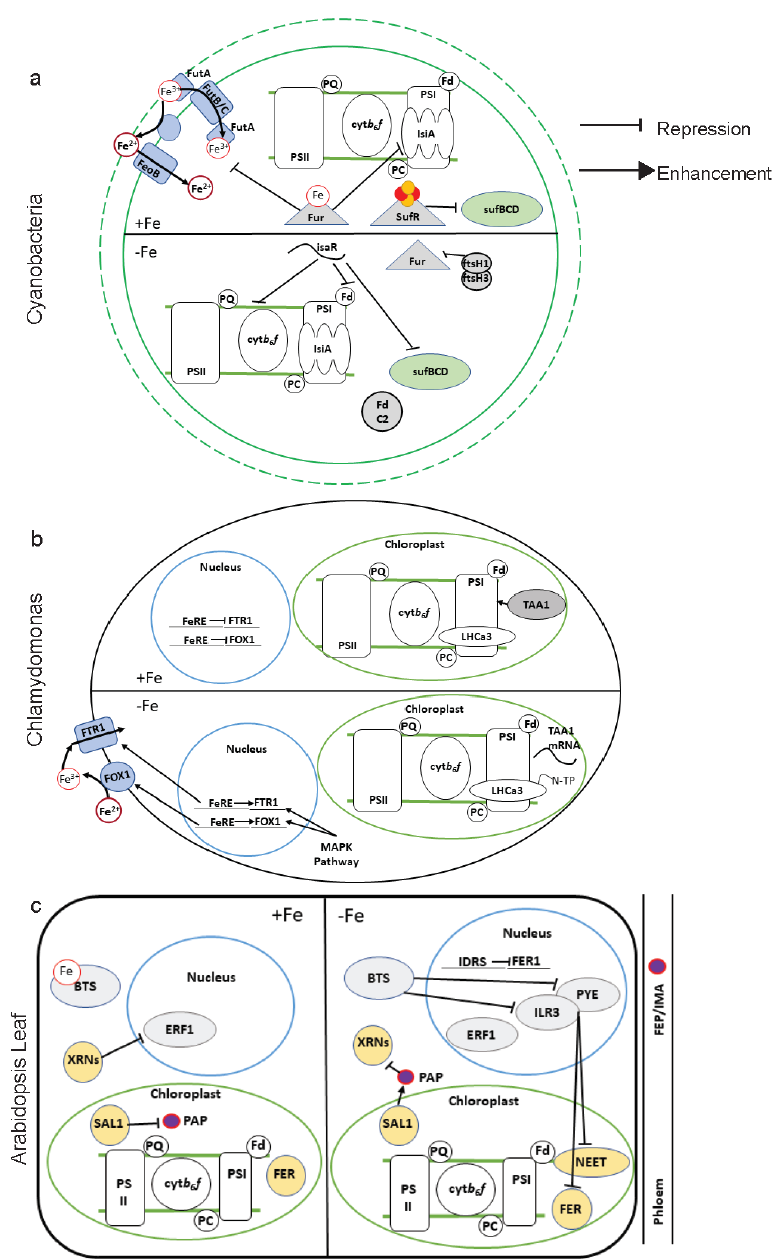
Figure 5. Regulation of Fe deficiency responses in photosynthetic organisms. ( a ) Regulation of Fe deficiency responses in Cyanobacteria. Fe Uptake Regulator (Fur) is the master regulator of Fe responses and acts as a transcriptional repressor under su ffi cient Fe. Fur represses the Fe uptake machinery as well as Iron Stress Induced protein A (IsiA). During Fe deficiency Fur is degraded by the protease complex, Filamentous H 1 / 3 (ftsH1 / ftsH3). The expression of the Sulfur Utilization Factor (suf) operon is fine-tuned by the combined action of SufR and the small RNA called Iron Stress Activated RNA 1 (IsaR1). SufR protein, when bound to an Fe–S cluster, represses the suf sca ff old to avoid excess Fe–S formation. IsaR1 is induced by Fe deficiency and represses transcripts for the sufBCD sca ff old during Fe deficiency together with Cytochrome- b 6 f (Cyt- b 6 f ) complex and Ferredoxin (Fd1). Ferredoxin C2 (FdC2) is hypothesized to regulate IsiA. ( b ) Regulation of Fe deficiency adjustment in Chlamydomonas. The Fe uptake machinery is regulated transcriptionally by Fe-responsive Elements in the promoters of the genes for the ferric iron permease (FTR1) and Ferric Oxidase 1 (FOX1) and by phosphorylation via the Mitogen Activated Protein Kinase (MAPK)